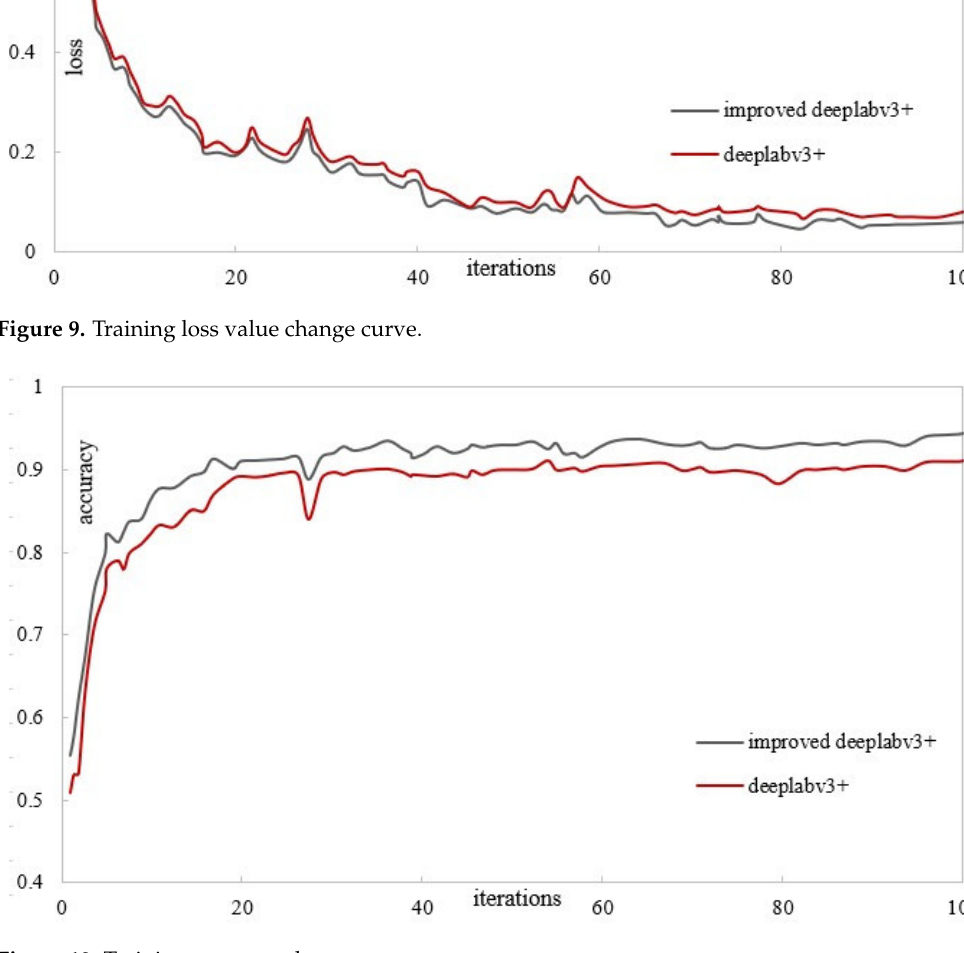
Figure 10. Training accuracy change curve. Table 3. The results of comparative experiments of Accuracy of different